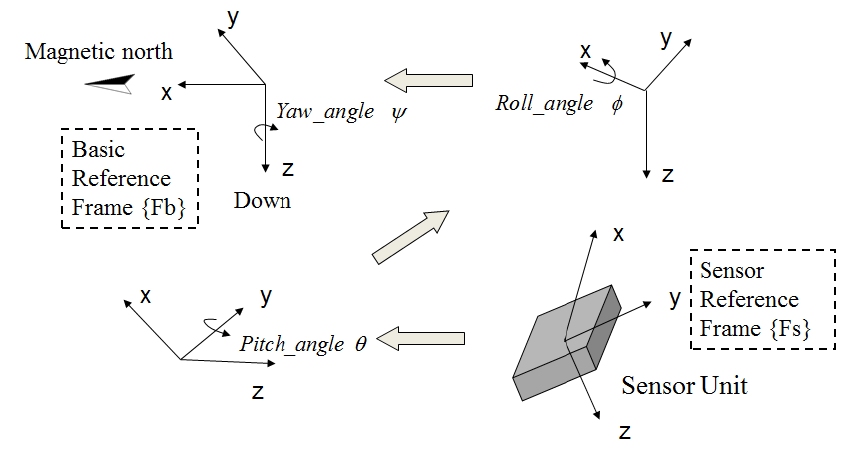
Figure 6. Rotation